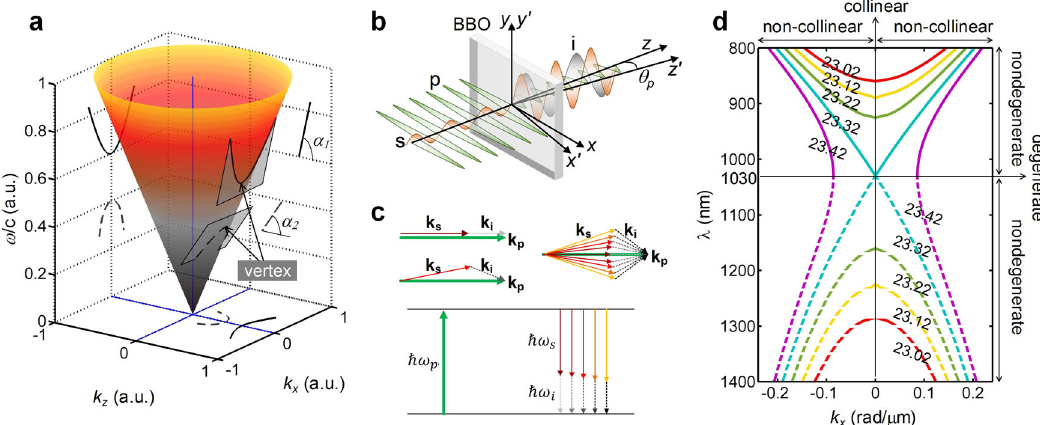
Fig. 1 Space-time (ST) spectra of space-time wave packet and optical parametric ampli fi cation (OPA). a ST spectrum of a ST wave packet lies in the intersecting curve between the light-cone and a tilted spectral plane parallel to the k x -axis (here two ST wave packets with spectral plane tilt angles α 1 > 45° and α 2 < 45°). Color of the light-cone schematically illustrates the frequency. b Three-wave coupling in the type-I OPA (here BBO). x-y-z and x ’ -y ’ -z ’ are lab and crystal coordinates. θ p is the pump angle with respect to the z ’ -axis. p , pump; s , signal; and i , idler. c Phase-matching (momentum conservation) and energy conservation diagrams for collinear OPA, non-collinear OPA, and ST wave packet OPA. Different colors of the arrows schematically illustrate different frequencies. d Phase-matching curves in a 515 nm pumped type-I BBO crystal when the pump angle θ p varies from 23.02° to 23.42° every 0.1° (distinguished by colors). Degenerate, nondegenerate, collinear, and non-collinear zones are given. When a signal/idler lies in the solid line and at one side of k x = 0, its idler/signal lies in the dash line and at the other side of k x =